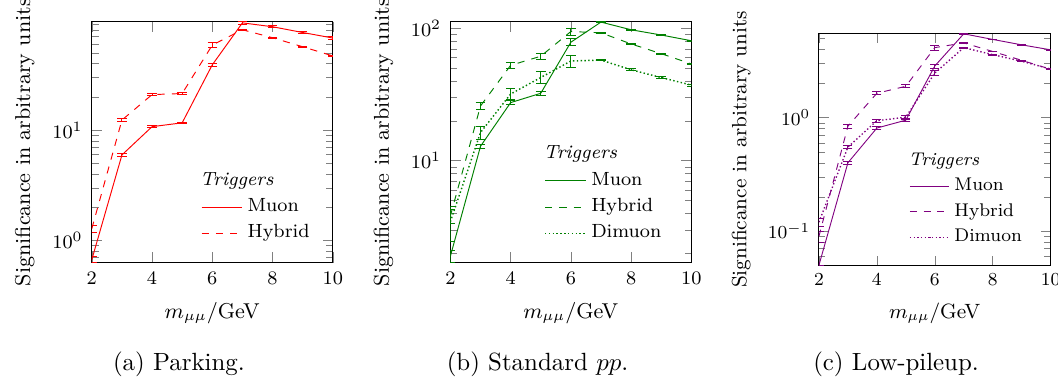
Figure 4 : Comparison of the significance to discover the displaced low- p as a function of the dimuon invariant mass. The comparison is shown for three of the five datasets: parking (a), standard pp (b), and low-pileup (c) for the three different triggers scenarios during Run 2. Since only the dimuon trigger applies to the scouting and heavy ion dataset, we omit these datasets